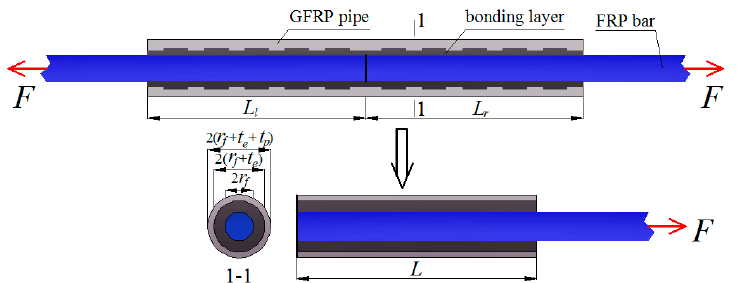
Figure 3. Theoretical model for FRP bars spliced with the proposed connection system.